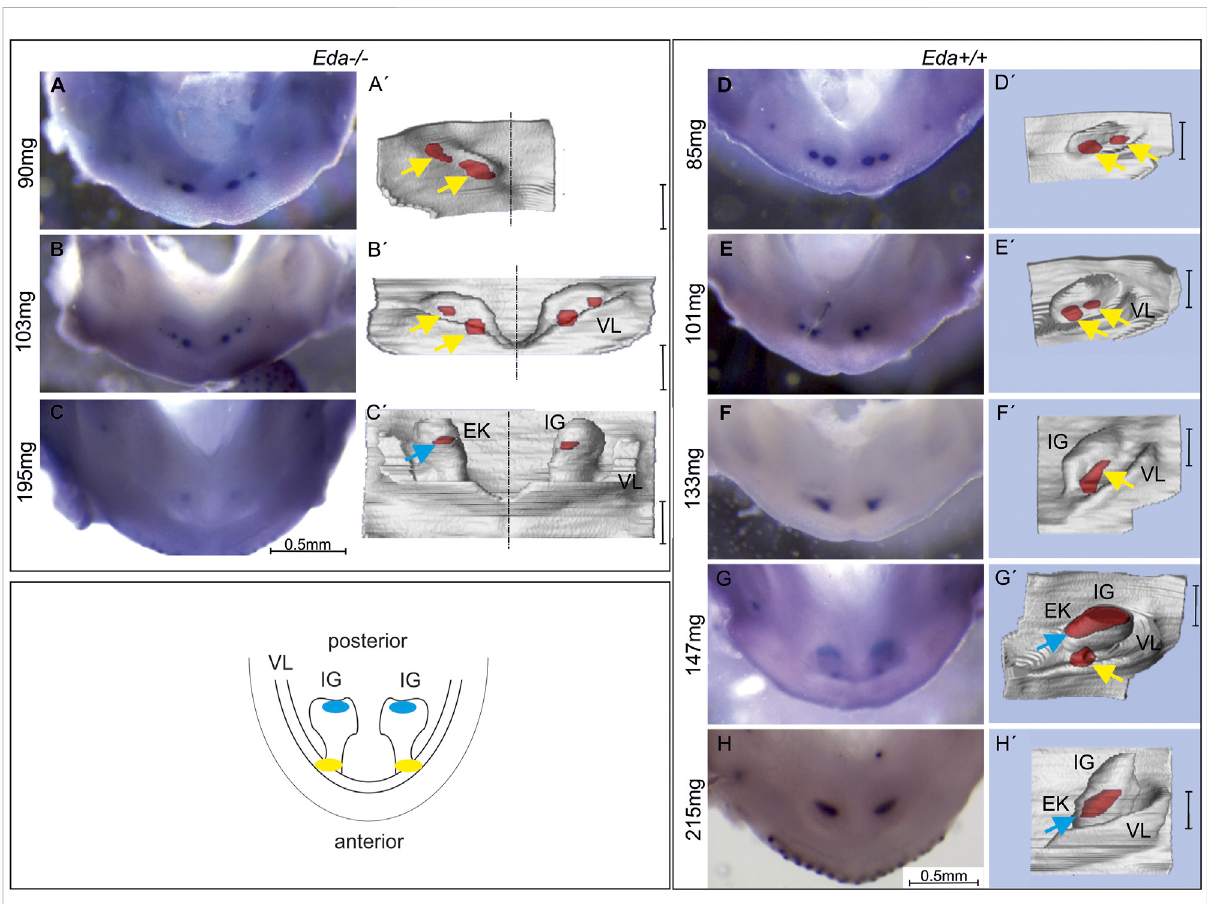
Shh expression in the lower incisor area of Eda − / − and Eda+/+ embryos. The expression was visualised by WISH (A – H) correlated with morphology of the developing dental and adjacent oral epithelia on 3D reconstructions of the same sample (A 9 – H 9 ) . The schematics shows the incisor region of the WT mouse mandible with developing incisor germ (IG). The anterior early initiation Shh expression (yellow) is located in the region of the epithelium adjacent to the externally invaginated vestibular lamina (VL). This region has been related to the rudimentary incisor generation present as a remnant of additional incisors apparent in the former ancestors (Hovorakova et al., 2011, 2013). The subsequently appearing posterior Shh expression (blue) is located in the region of prospective enamel knot in the functional incisor germ. In Eda − / − embryos at ED13.5, anterior, early super fi cial Shh expression region (yellow arrow) split into two spots was detected (A,A 9 ,B,B 9 ) . In the more advanced embryo Eda − / − (ED14.5, 195 mg) the posterior expression region (blue arrow) was detected in the functional incisor bud (C,C 9 ) . In Eda+/+ embryos at ED13.5, anterior, super fi cial initiation Shh expression localised in two spots in each jaw quadrant was detected (D,D 9 ,E,E 9 ) . In the developmentally less advancedembryo Eda+/+ atED14.5(133 mg),onlyoneinitiation Shh expressionregionwasdetectableintheanteriorpartofincisorarea (F,F 9 ) .Inthe more advanced embryo at ED14.5 (147 mg) anterior and posterior Shh expression regions co-existed for a short period (G,G 9 ) . The posterior Shh expression area (related to the appearing enamel knot (EK) of the functional incisor) was detected on the tip of functional incisor bud (G 9 ) . In the developmentally most advanced embryo (215mg, ED15.5) only the posterior Shh expression remained visible (H,H 9 ) . Bar in 3Ds indicates 100